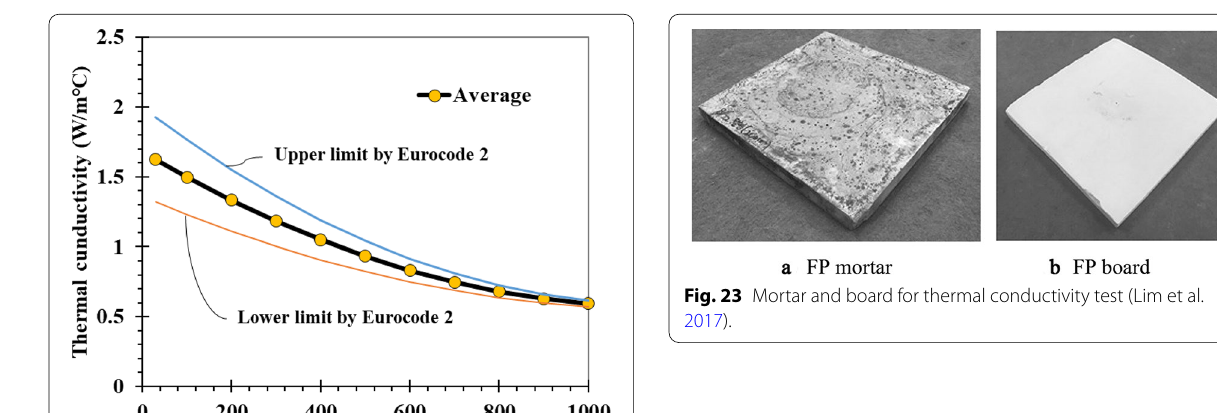
Fig. 21 FE modeling of specimens.